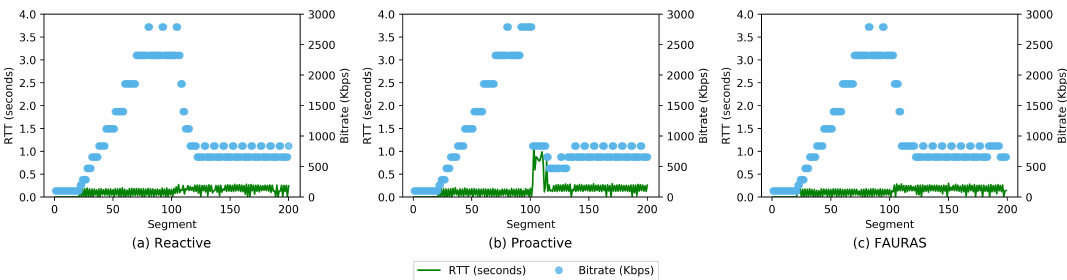
Figure 10. The per-segment bitrate and RTT of the client a 1 in subscenario 2-B. Table 10. The average bitrate of the client a 1 after the new fair bandwidth is assigned (from segment 100th to segment 200th) in subscenarios 2-A and 2-B. Subscenario Reactive Proactive